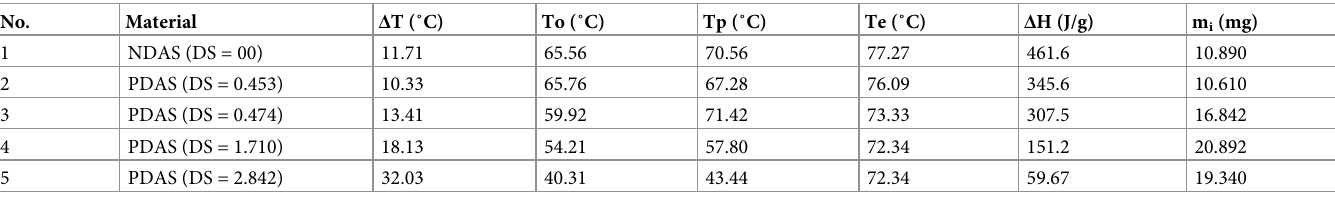
Table 4. Experimental values of onset temperature (To), peak temperature (Tp), end set temperature (Te), enthalpy change ( Δ H), and initial mass (m i ) for NDAS and PDASs with different DS (DS = 0.453, 0.474, 1.710 and 2.842). No.